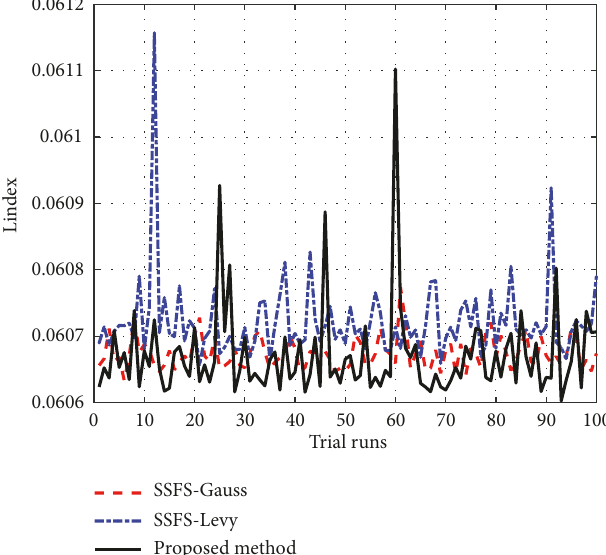
Figure 12: Comparisons of 100 runs for L-index objective of IEEE 118-bus system obtained by three methods.